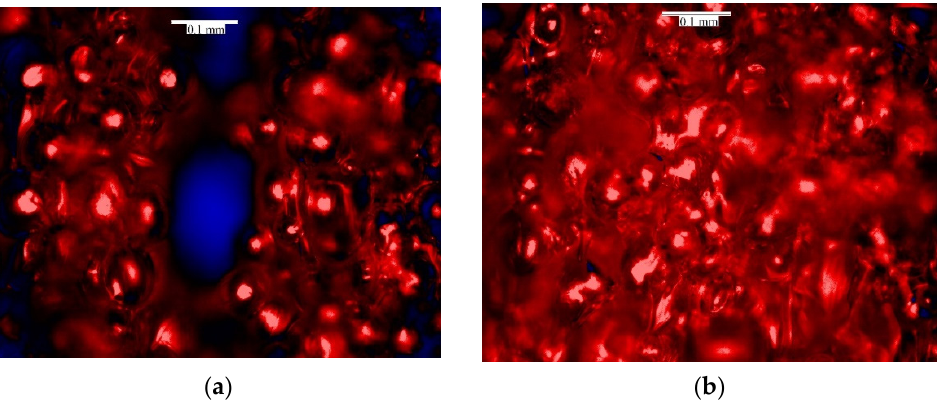
Figure 2. Microscopic images of 3D-printed samples in 250 °C for ( a ) 25%, ( b ) 35% infill flow rates.